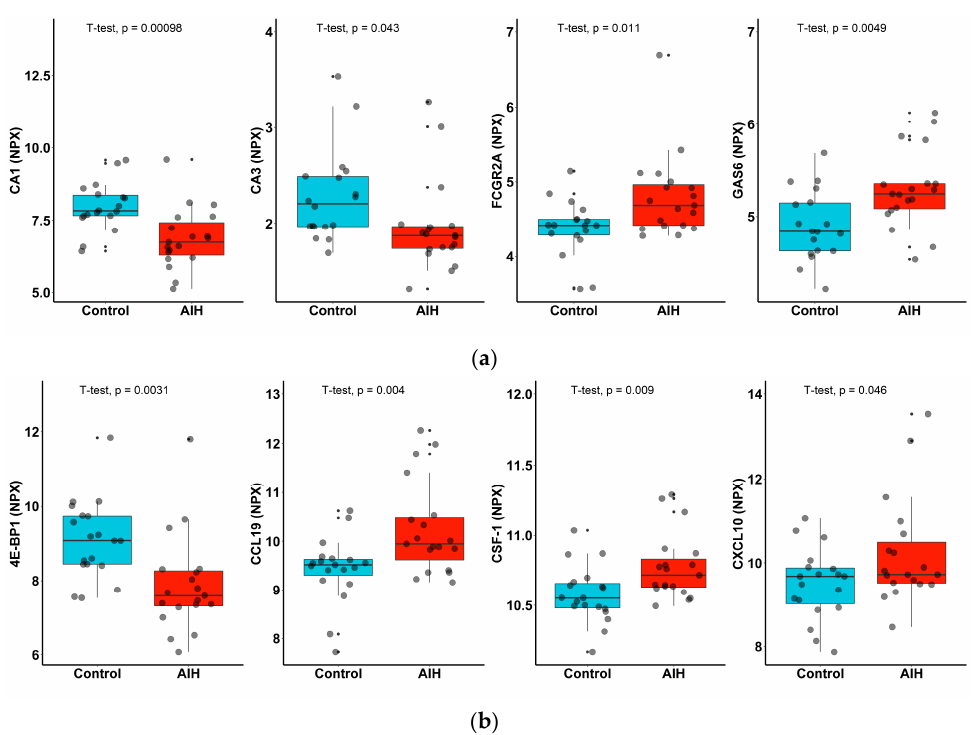
Figure 5. Levels of serum proinflammatory markers in patients with AIH (red) and controls (blue). Boxplots of up-regulated (GAS 6, FCGR2A, CXCL10 and CCL19) and down-regulated proteins (CA1, CA3 and 4E-BP1) in the ( a ) Cardiometabolic and ( b ) Inflammation panels. Un-paired t -test with corresponding p values are shown on plots for each